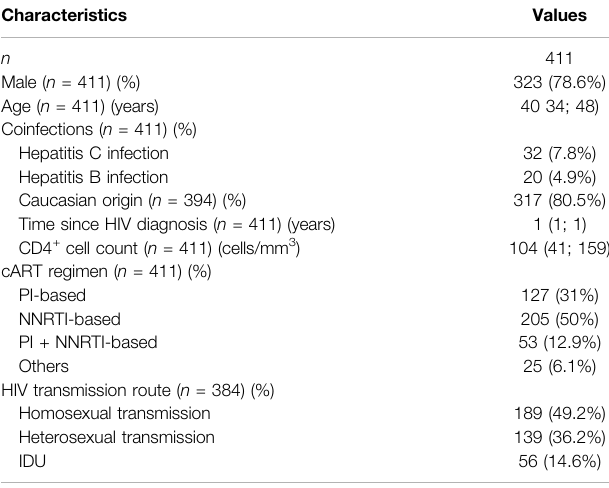
TABLE 1 | Clinical and epidemiological characteristics at baseline of HIV infected patientswhostartedcARTwithverylowCD4+T-cellscount( < 200cells/mm 3 ).